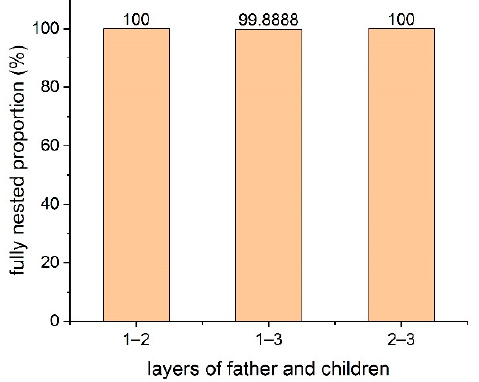
Figure 8. Accuracy for definite nested inference.